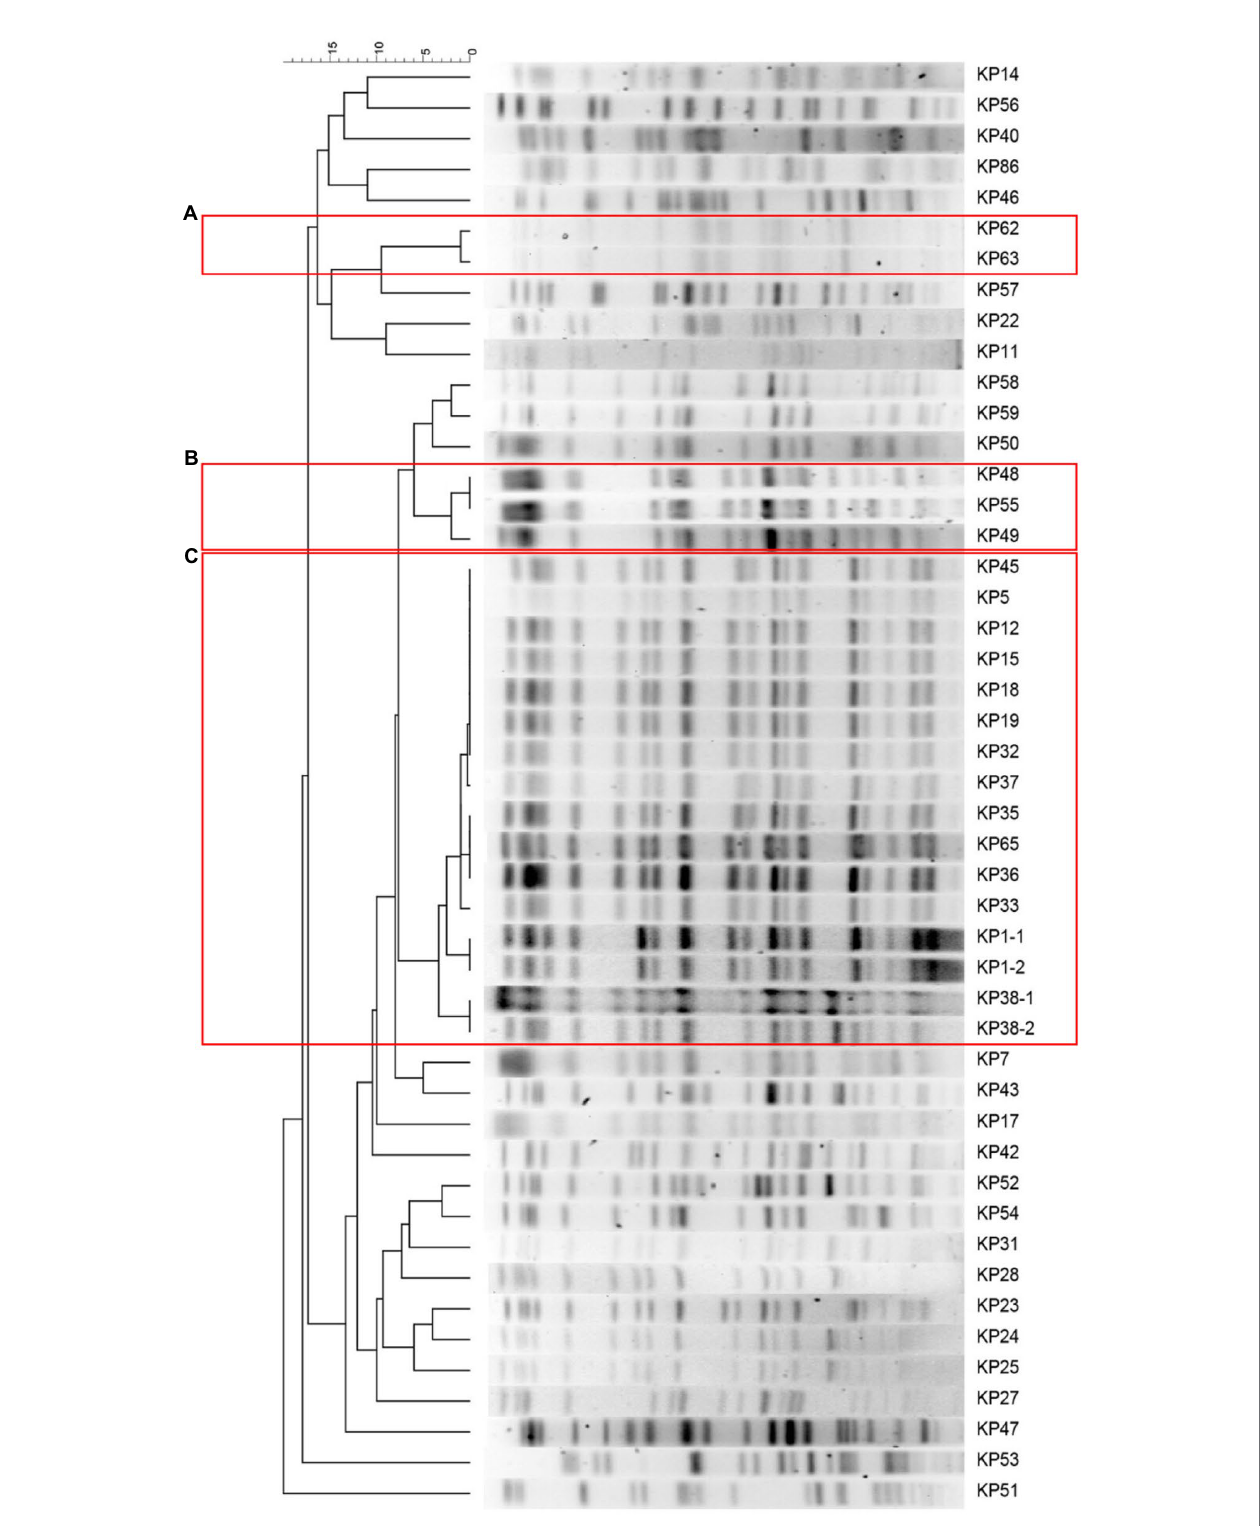
FIGURE 1 | Clustering of the 16 carbapenem-resistant Klebsiella pneumoniae (CRKP) isolates based on pulsed-field gel electrophoresis (PFGE) profiles. The information of strain ID is listed to the left of the patterns. The three predominant PFGE cluster (A) , (B) , and (C) are represented by red